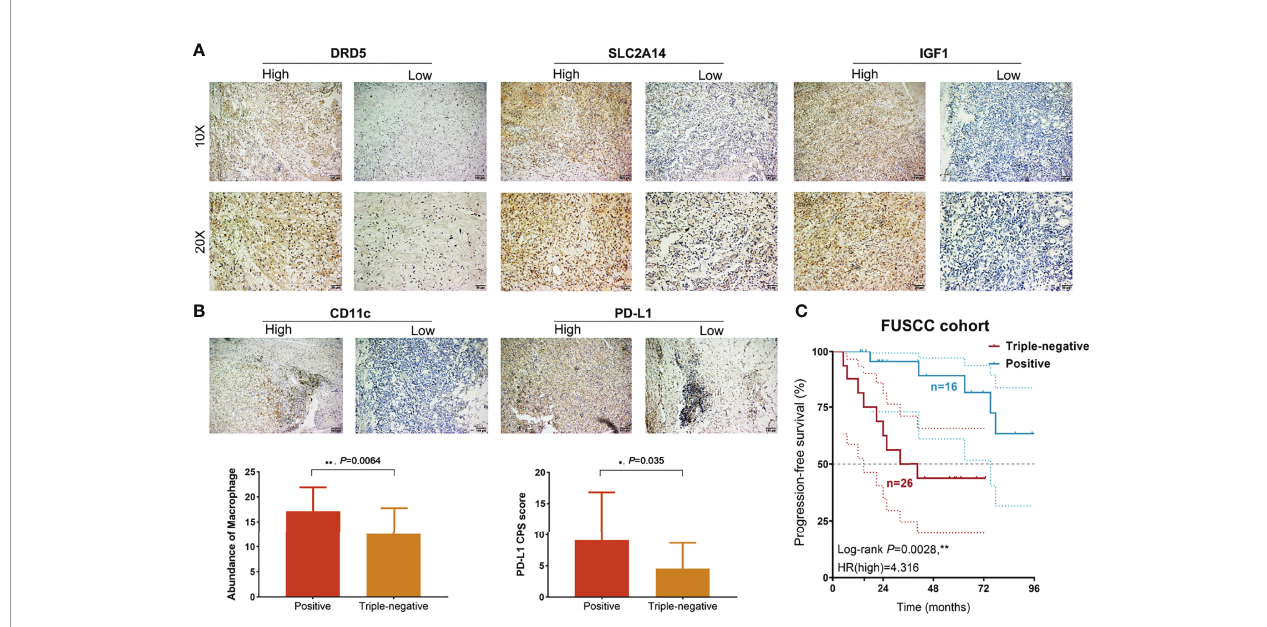
FIGURE 9 | Prognostic and immunological implications of CDI in a real-world validation cohort. (A) Immunohistochemical analysis showed DRD5, SLC2A14, and IGF1 expression levels in BCa samples. (B) Staining of CD163 and PD-L1 expression levels and comparison of macrophage TAMs abundance and PD-L1 CPS score using unpaired t-test. (C) Kaplan – Meier s urvival analysis of positive and triple-negative staining groups for patients with BCa treated with immunotherapies (n = 42). ** P <